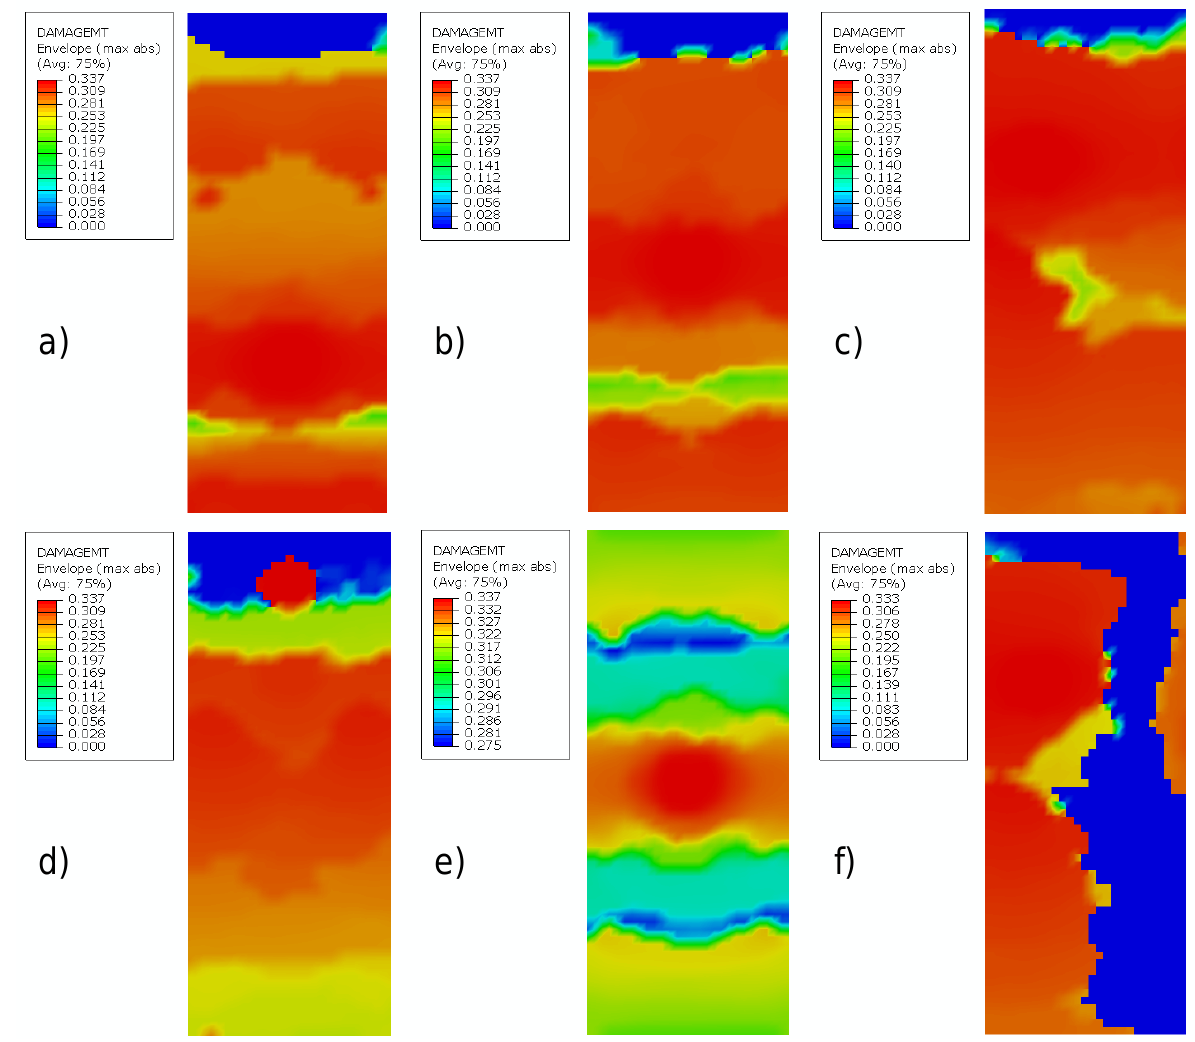
Figure 4. Matrix-tension damage distributions of the considered six cases at 5 ms. ( a ) 30%, root clamped; ( b ) 50%, root clamped; ( c ) 70%, root clamped; ( d ) 90%, root clamped; ( e ) 50%, root & tip clamped; ( f ) 70%, root & side